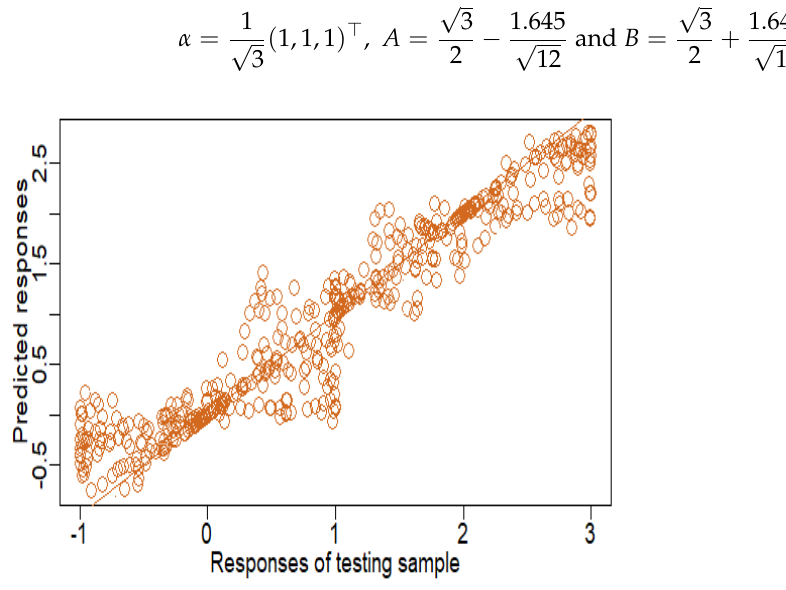
Figure 1. Responses of testing sample versus Predicted responses (step